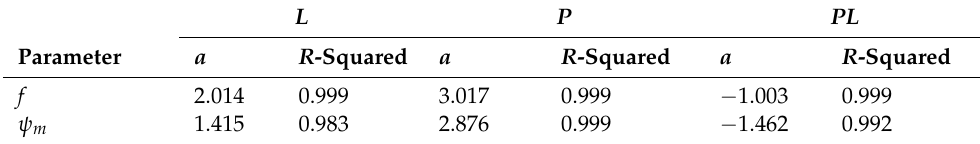
Table 9, the aerodynamic power is almost related to the third power of frequency and sweeping amplitude. Table 9. Coefficients for the power relationship calculated from the log-transformed data. L P PL